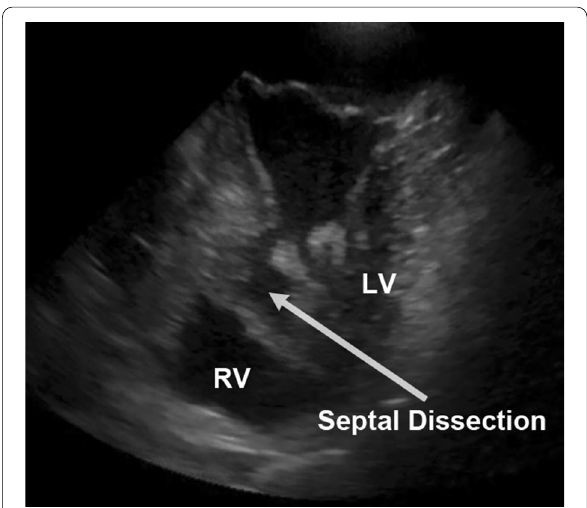
Fig. 1 Transesophageal echocardiogram. A ventricular septal dissection is shown with communication to the left ventricle via a small orifice-generating aneurysm. LV left ventricle, RV right ventricle